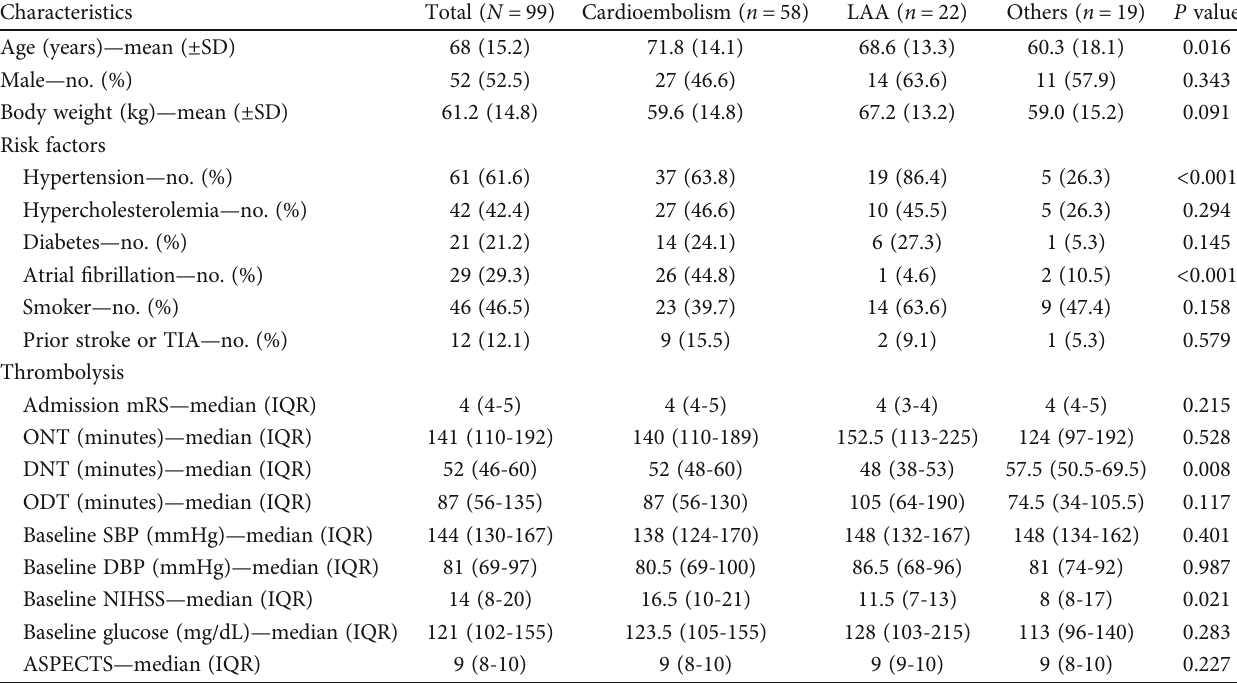
Table 1: Baseline characteristics of